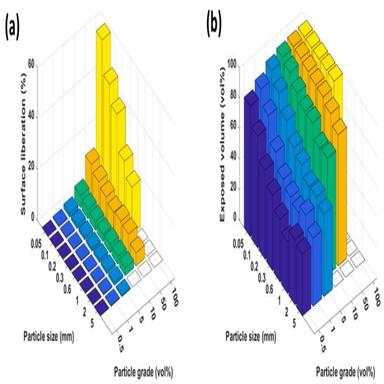
(a) mean surface liberation for particles and (b) mean exposed volume of Cu mineral grains for particles; both as a function of particle size and grade. Note that blank bars mean no data.